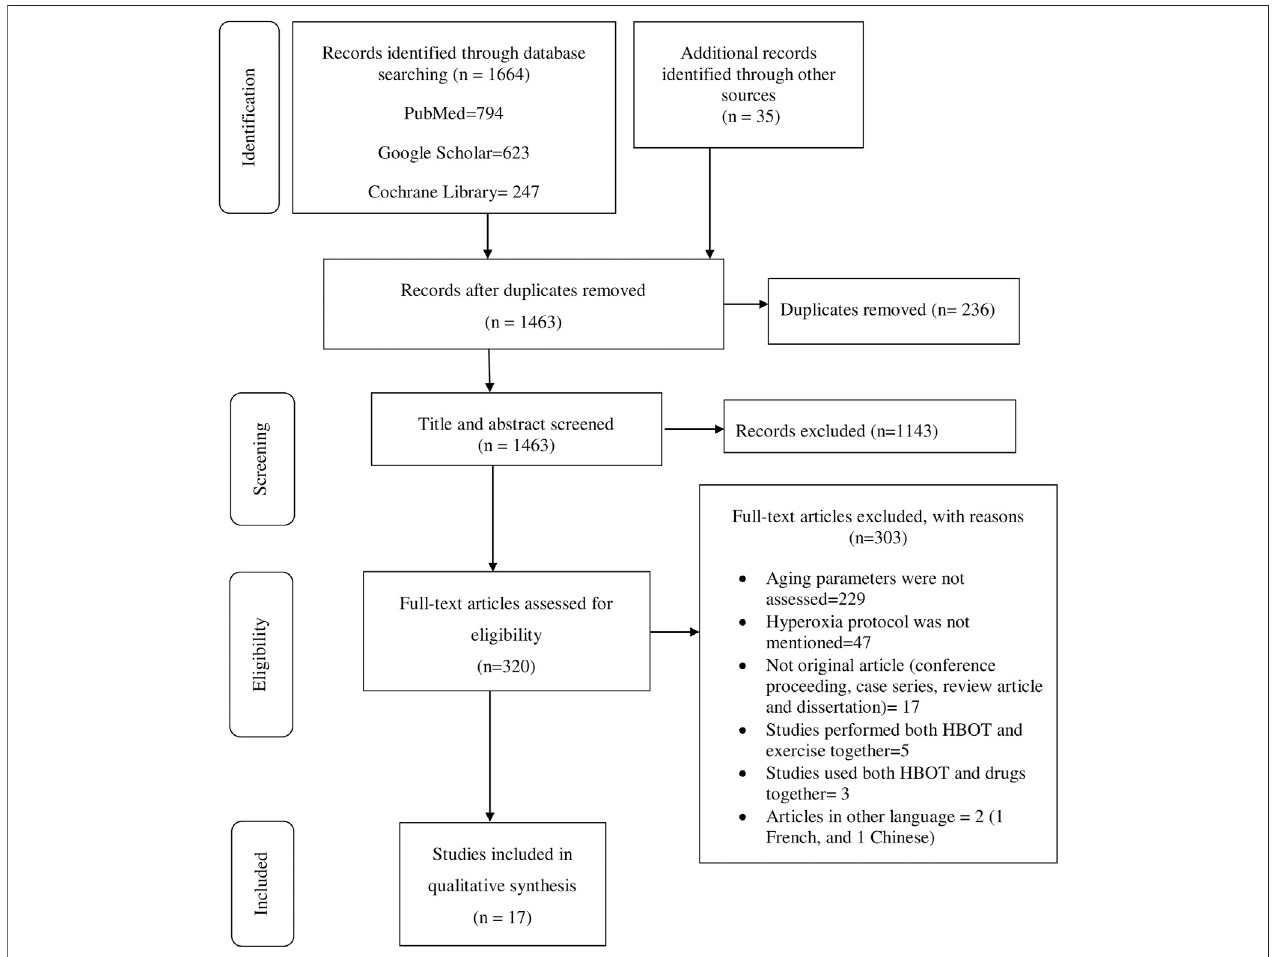
FIGURE 1 | PRISMA fl ow diagram shows the search strategy and screening of eligible studies at different levels of the review process (Moher et al., 2009).